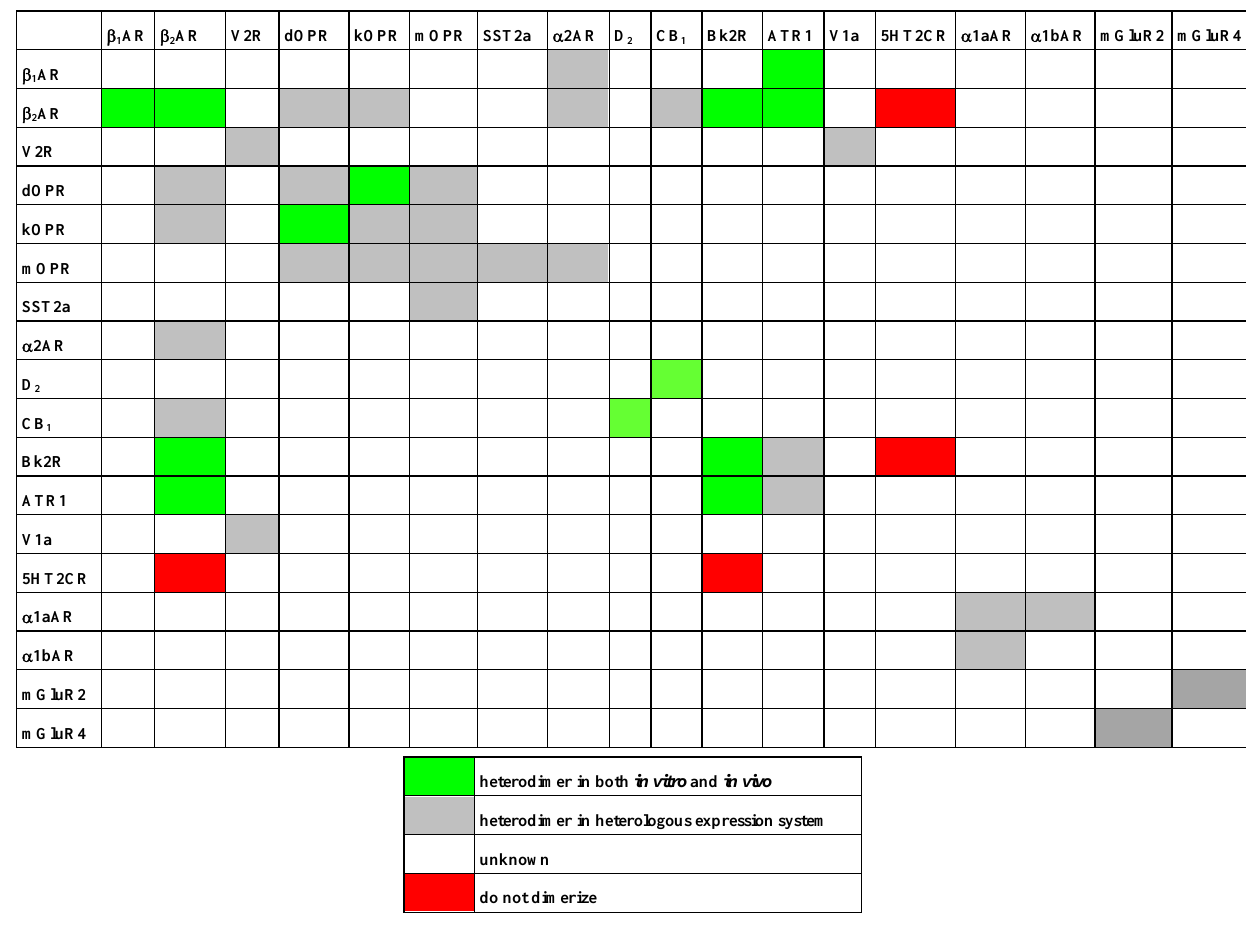
Table 1. Heterodimerization of GPCRs